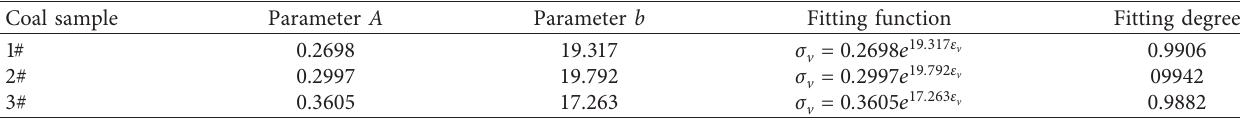
Figure 6: The stress-strain curve of the compacted broken coal. (a) Coal sample 1#. (b) Coal sample 2#. (c) Coal sample 3#. Table 3: The fitting parameters of the stress-strain curve.